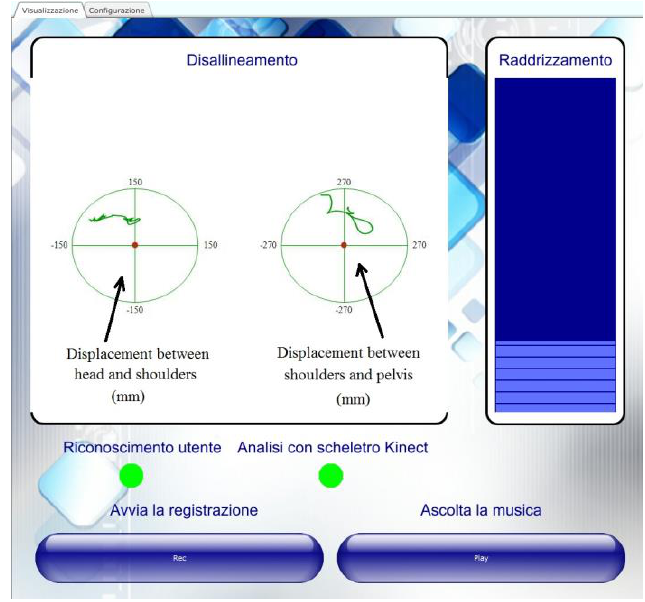
Figure 11. Posture rehabilitation user interface